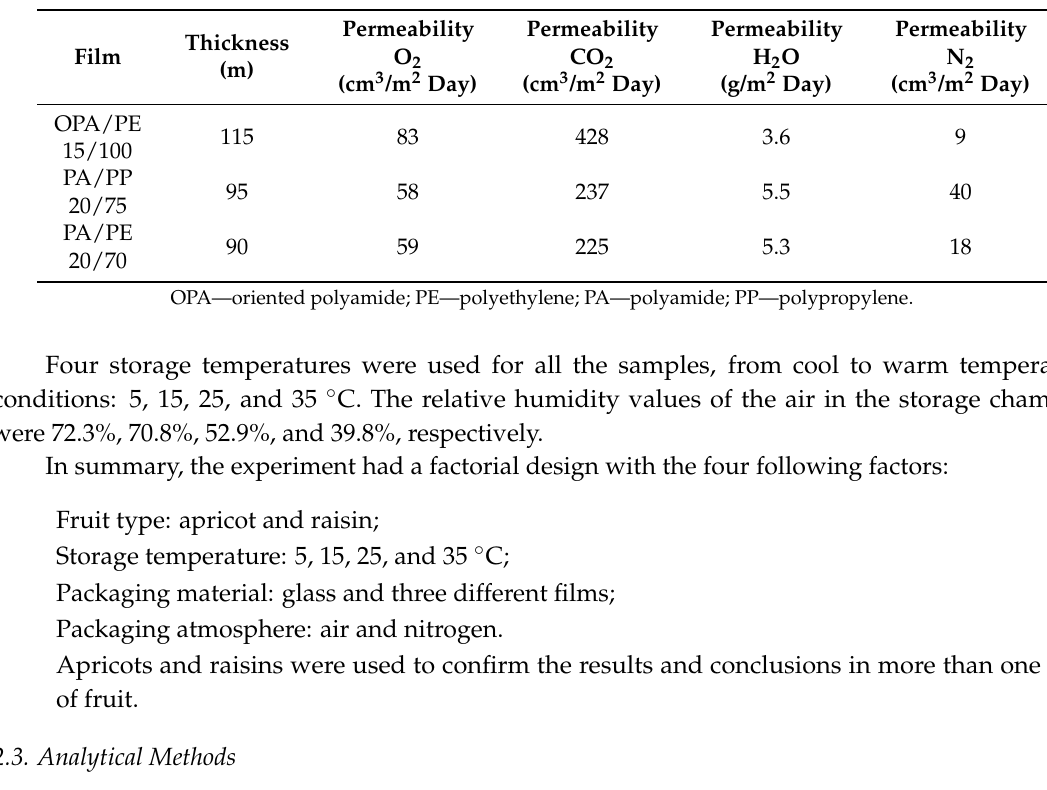
Table 1. Properties of the films used to seal the polypropylene